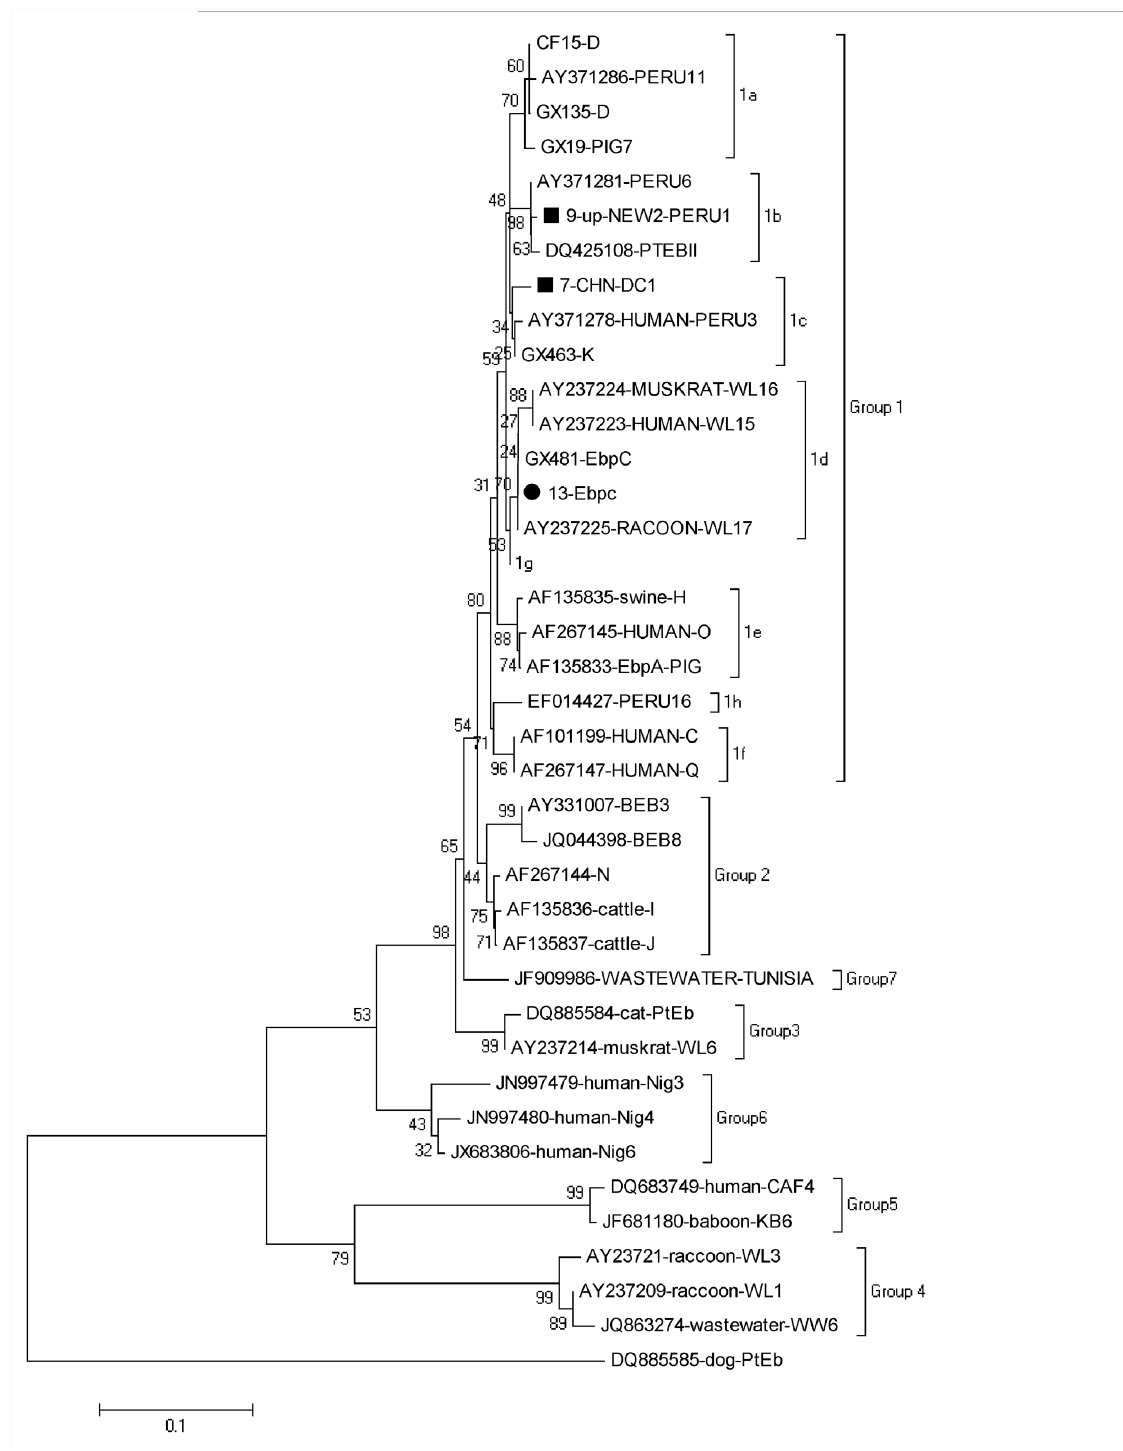
Fig 1. Phylogenetic relationship of Enterocytozoon bieneusi genotypes identified in the present study and other known genotypes deposited in GenBank was inferred by a neighbor-joining analysis of ITS sequences based on genetic distance by the Kimura two-parameter model. The numbers on the branches are percent bootstrapping values from 1,000 replicates. Each sequence is identified by its accession number, host origin, and genotype designation. The group terminology for the clusters is based on the work of Zhao et al. [26]. The squares and circles filled in black indicate novel and known genotypes identified in this study,